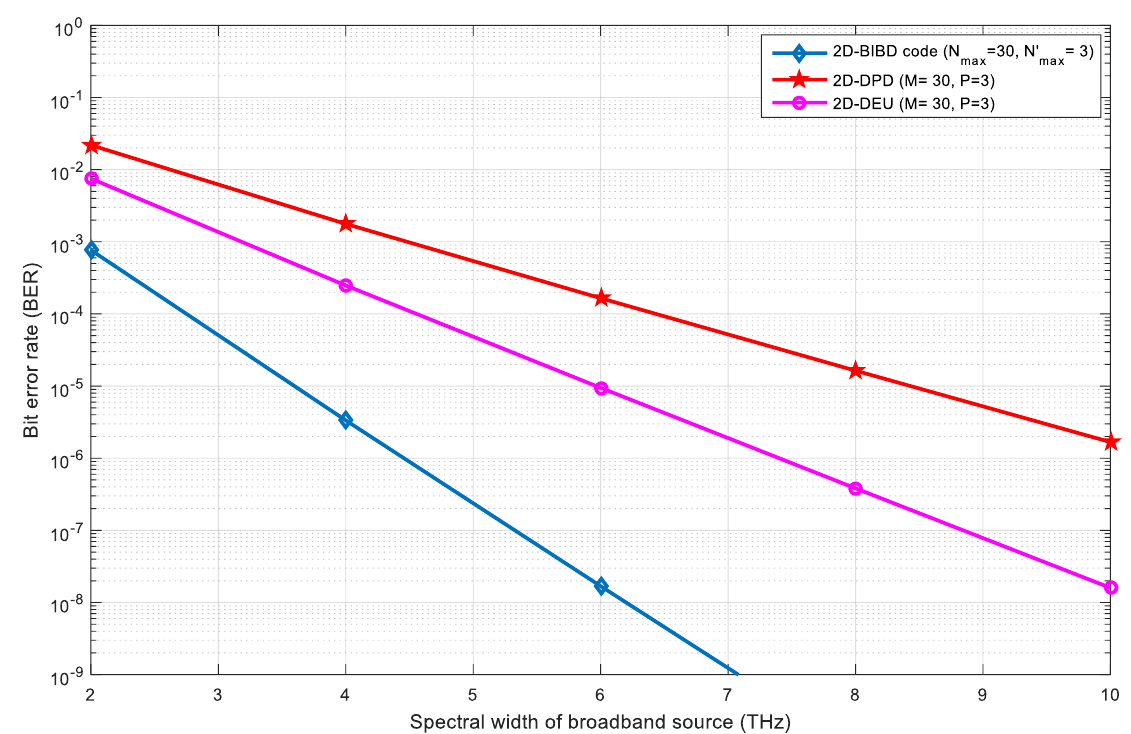
Figure 6. Relationship between BER and broadband source spectral width with 20 active users and a data rate of 622Mbps.